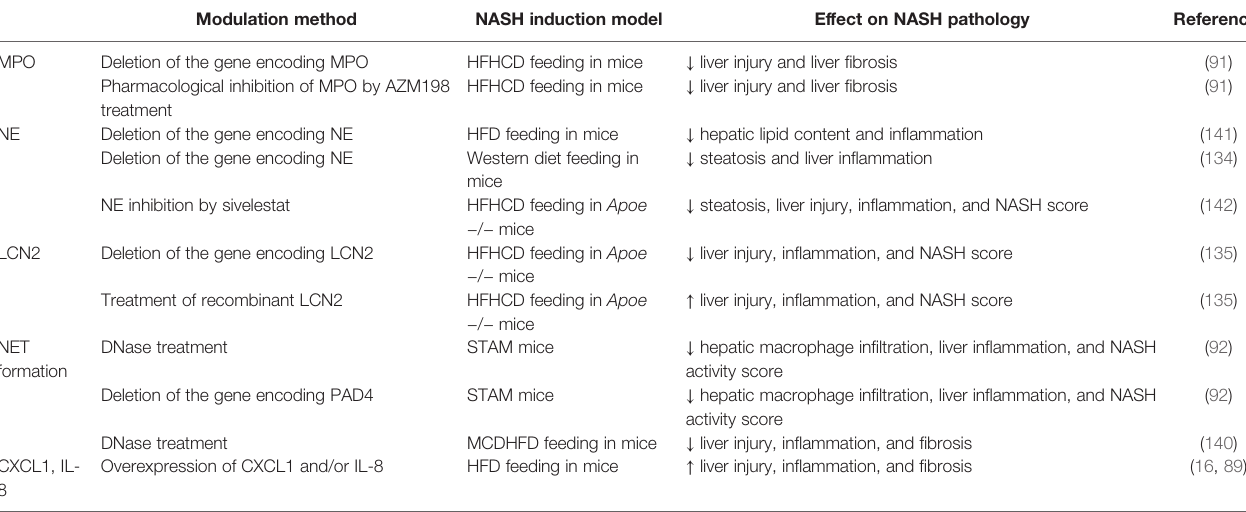
TABLE 3 | Modulation of neutrophil-related factors that affect the degree of experimental